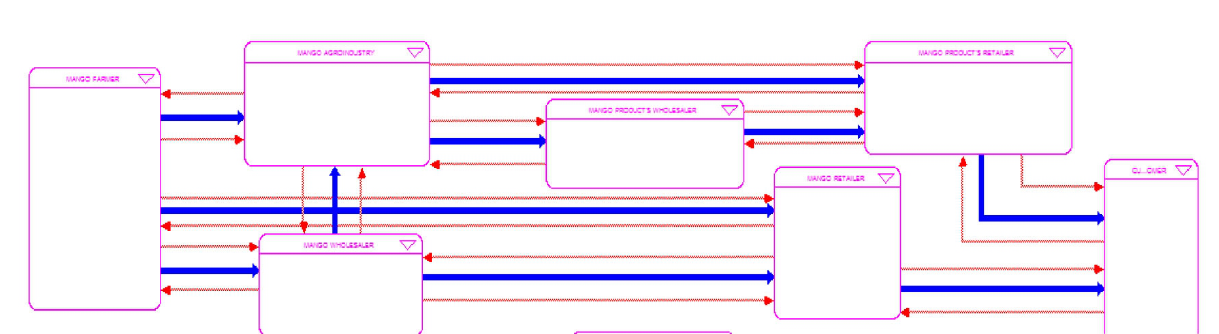
Figure 3. Model for 3 SCPF in iThink of the echelons, their material (blue) and information flows